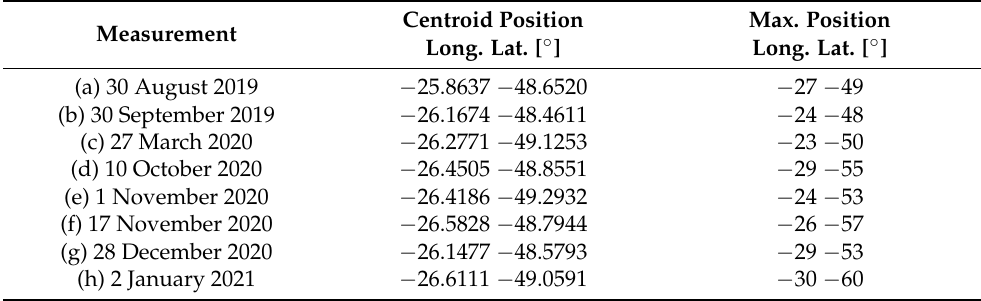
Table 2. Development of the position of the SAA. Measurement